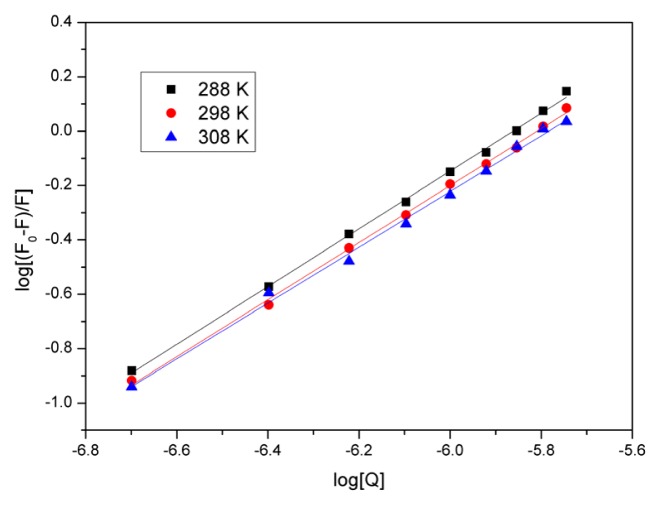
Plots of log[(F0 − F)/F] versus log[Q] for eupatorin quenching effect on BSA fluorescence at different temperatures. CBSA = 3.0 × 10−7 M; pH 7.4; λex = 280 nm, λem = 290–500 nm.